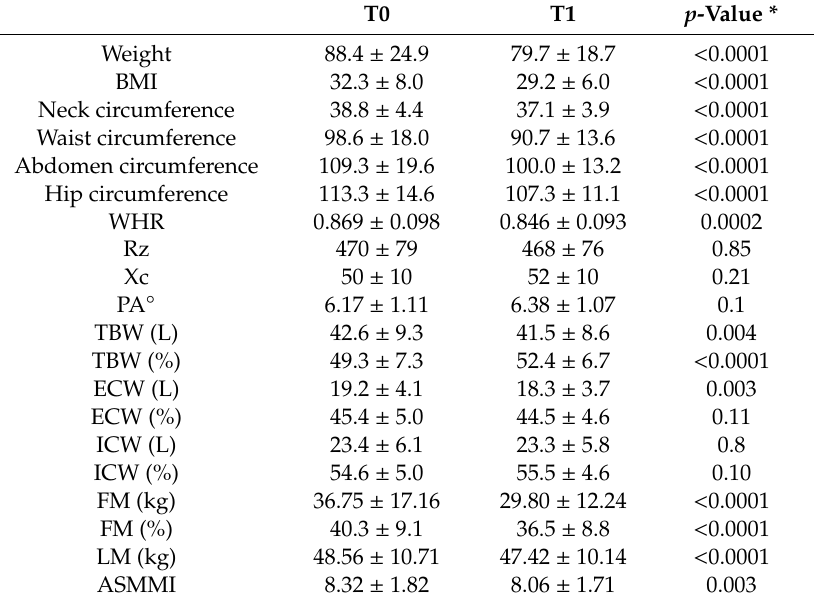
Table 1. Anthropometric and body composition’s characteristics at T0 and